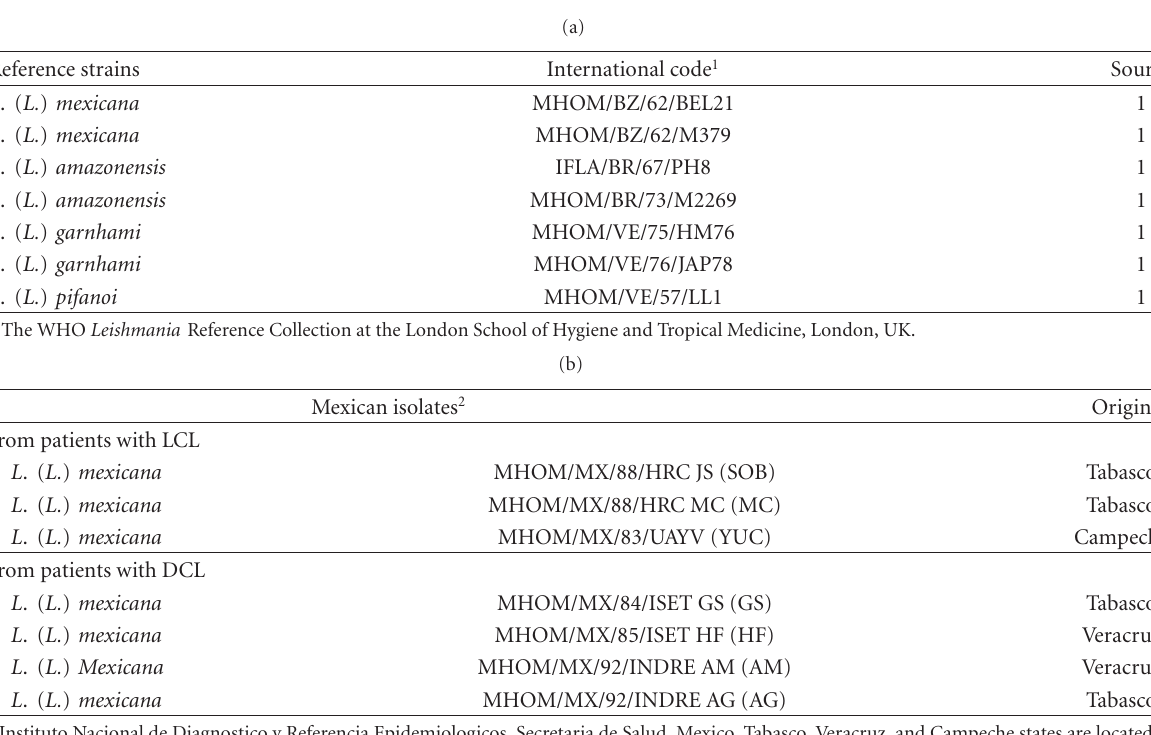
Table 1: Mexican isolates and reference strains of Leishmania mexicana complex used in this study.